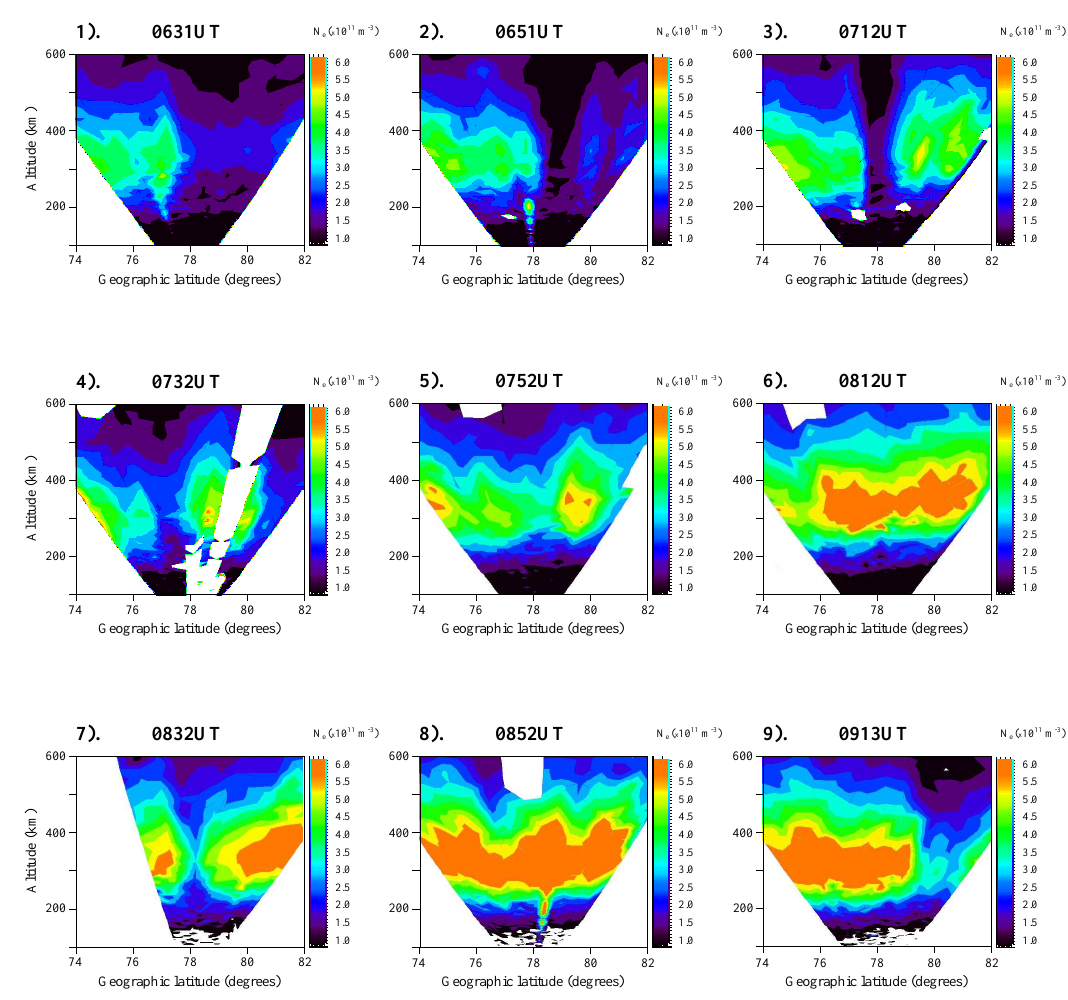
Fig. 2. Electron densities measured by the ESR during successive latitudinal scans of the radar beam in the NOOK UK special programme broadly between 06:30-09:30 UT on 26 August 2000. The start time for each scan where the radar beam is at its most northerly position is shown on the